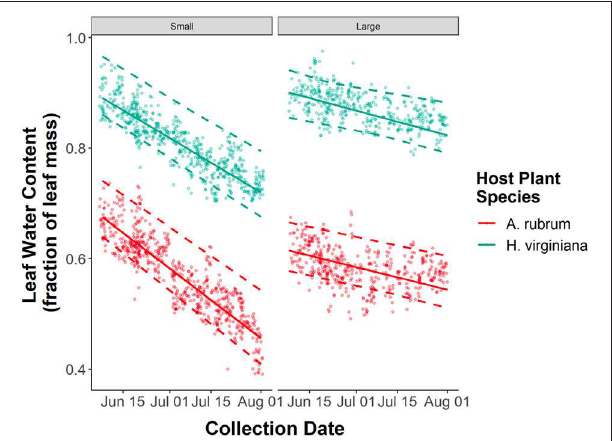
FIGURE 6 | The probability of parasitism for dietary specialist and generalist subsets of the caterpillar community in relation to forest patch size. Solid lines represent the predicted values from GLMMs, dashed lines represent 95% confidence intervals around the predictions, points are the raw data, and the size of the point represents the sample